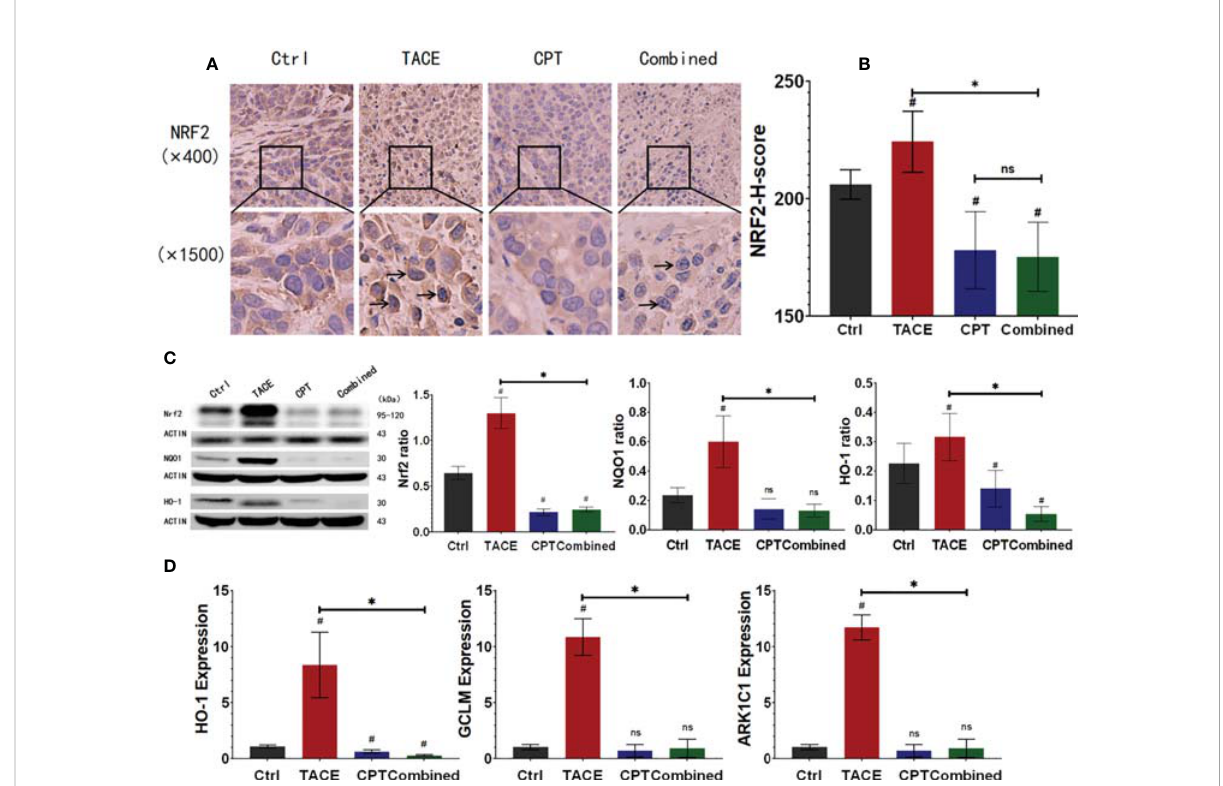
FIGURE 3 Camptothecin (CPT) inhibits the expression and functional activity of nuclear factor E2-related factor 2 (NRF2). (A, B) After DEB-TACE, the expression of NRF2 in the tumor area increased; following the addition of CPT, the expression of NRF2 in the Ctrl and Combined groups decreased to a lower level. (A) More obvious nuclear translocation of NRF2 in the TACE group, and lighter staining in the nucleus of the combined group could be observed. (C) The protein expression of NRF2, NQO1, and HO-1 in tumor tissue. (D) The RNA expression and assay of HO-1, GCLM, and ARK1C1 by qPCR. * P < 0.05, # P < 0.05, ns P >